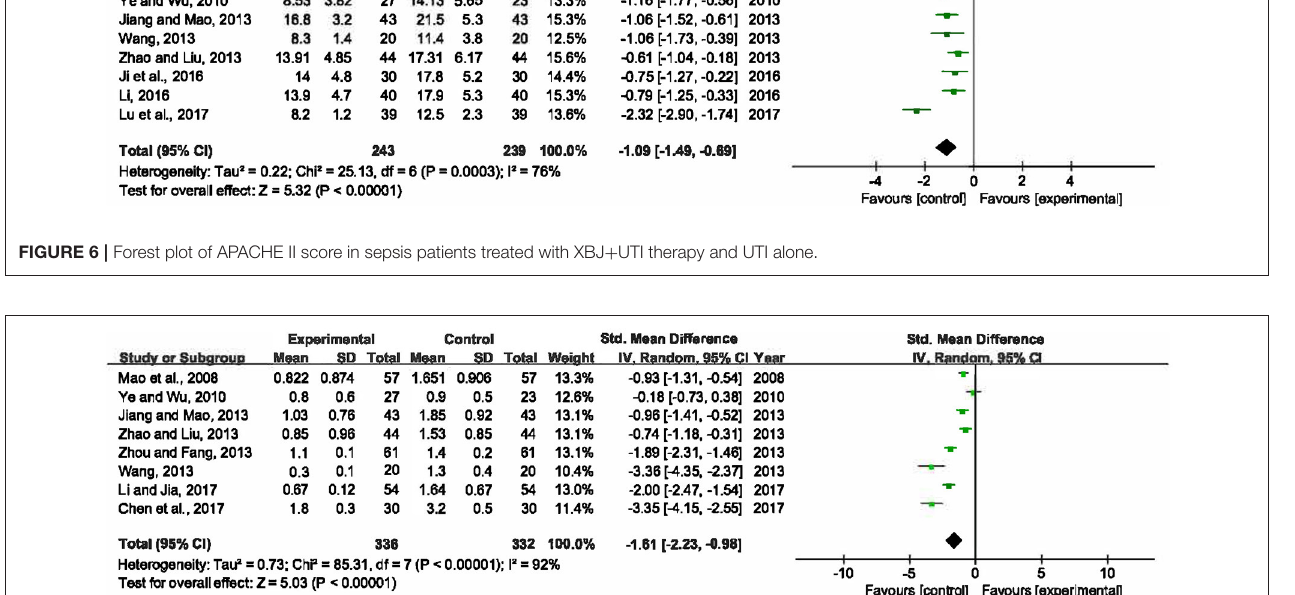
Figure 9 indicated that the outcomes of 28-day mortality were very similar, which had relatively good